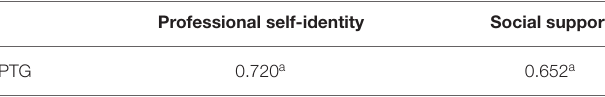
TABLE 5 | Correlation analysis of PTG with professional self-identity and social support ( N =